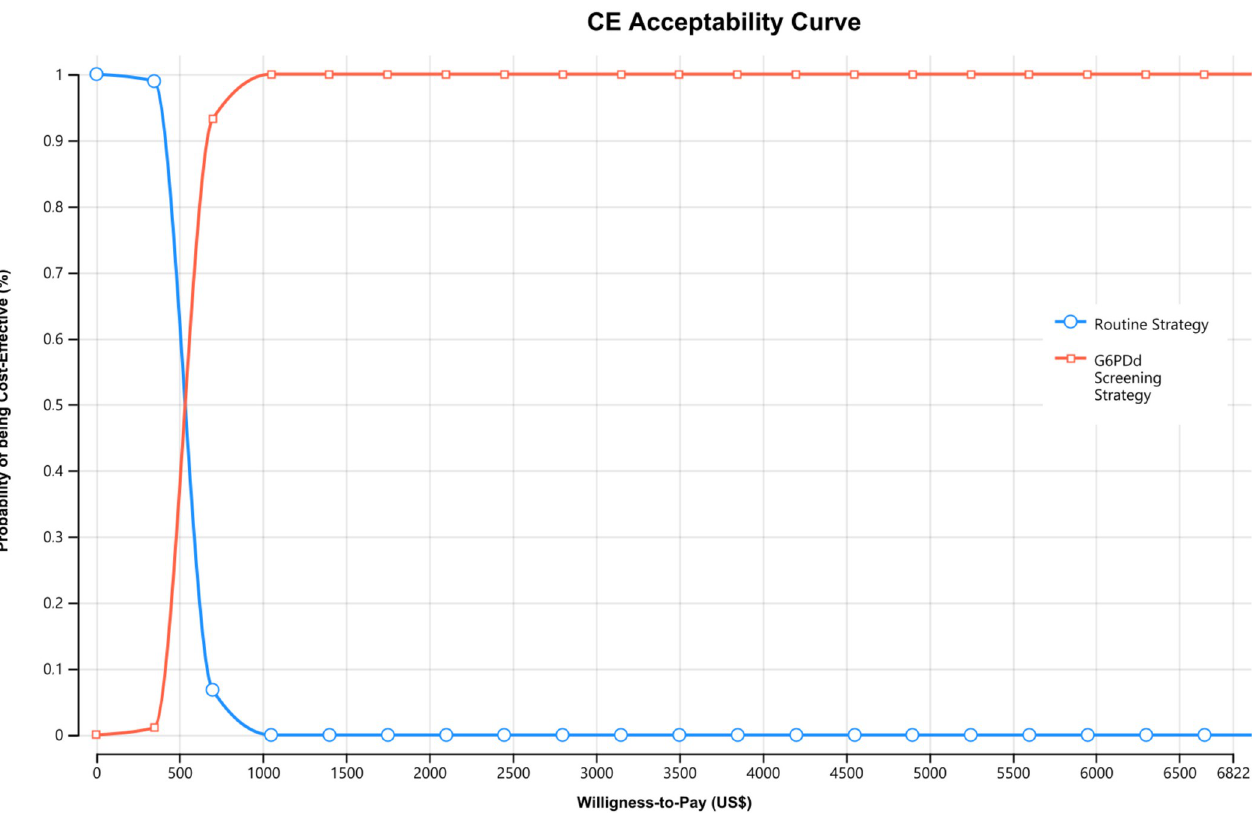
Fig 3. Cost-effectiveness acceptability curve of routine strategy versus G6PDd screening strategy. Brazilian Amazon, 2020.